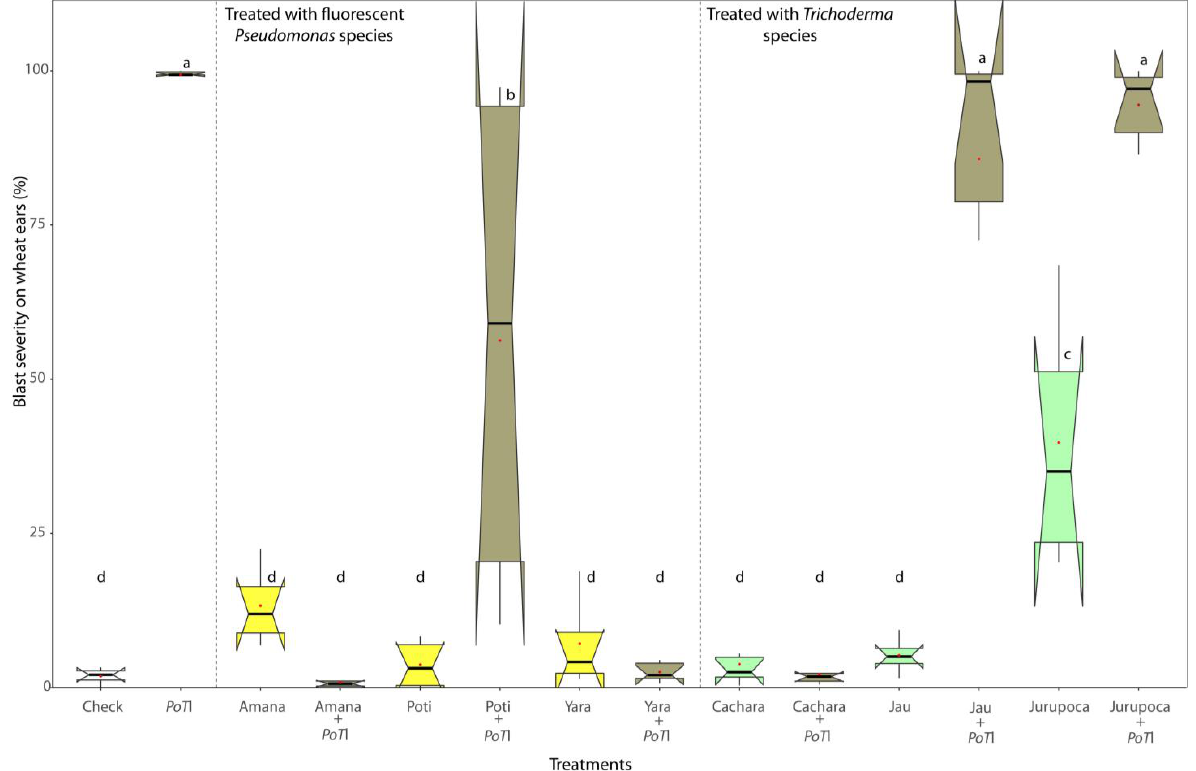
Figure 7. Severity of head blast on wheat cv. Sossego inoculated or not with Pyricularia oryzae Triticum lineage ( PoTl ), individually treated with three strains of fluorescent Pseudomonas species (strains ‘Amana’, ‘Poti’ and ‘Yara’) or three strains of Trichoderma species (strains T. koningiopsis ‘Cachara’, T. virens ‘Jau’ and T. lentiforme ‘Jurupoca’) as potential biocontrol agents. The plants were inoculated with a mixed inoculum composed of three PoTl isolates (12.1.047, 12.1.146 and 12.1.207) at ≈ 10 4 conidia mL − 1 . Means followed by the same letters (a–d) are not significantly different ac- cording to the Scott–Knott test at p ≤